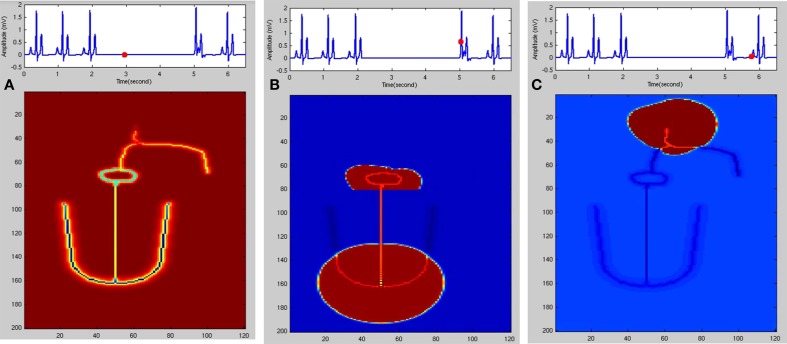
Sinus Pause. Figures in the top row denote ECG waveforms, while the images in the bottom row represent the corresponding state of activation of the 2DWH model. (A) The red dot shown in the ECG waveform indicates the paused state of the model depicted in the bottom row. The corresponding image below shows that there is no activity in the model (B) after sinus pause a junctional escape occurs which drives the ventricles in the anterograde pathway and the atriainretrograde pathway. Since atrial activity is occurring during ventricular depolarization, P wave is obscured in QRS complex. (C) After junctional escape a normal sinus rhythm originates from the SAN.